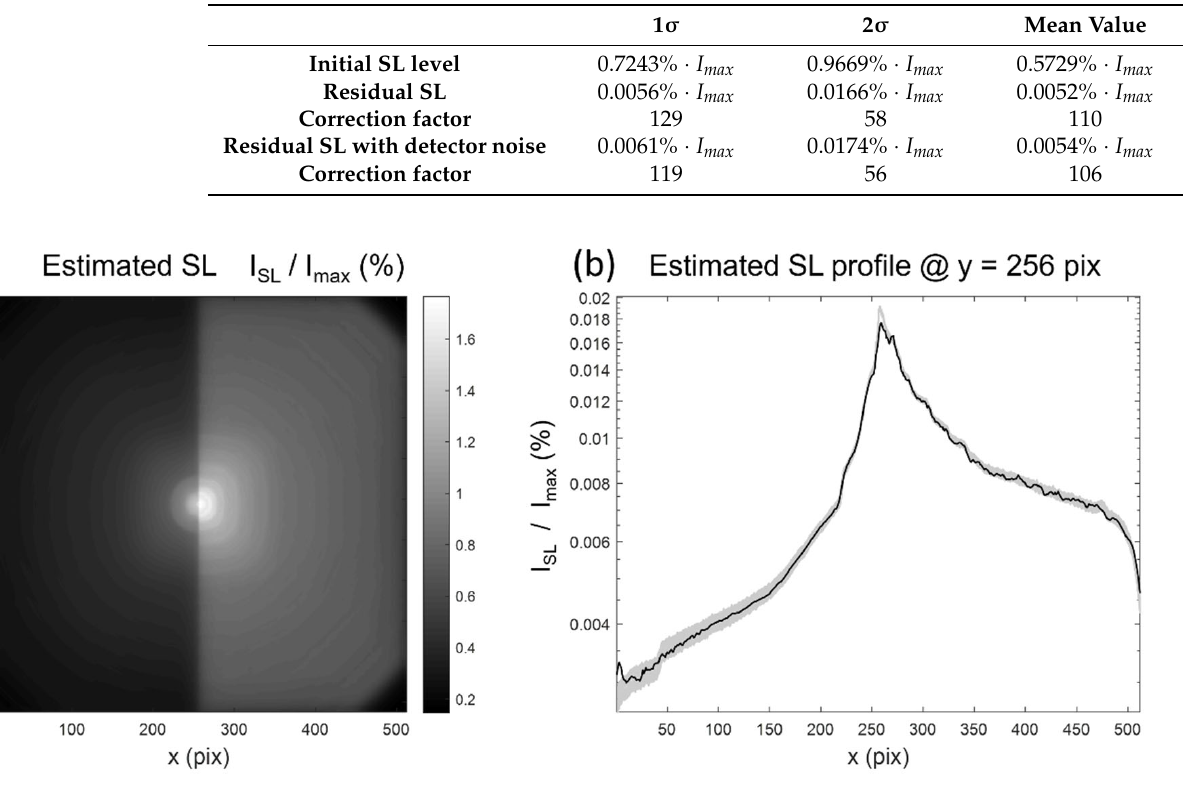
Figure 12. ( a ) SL for the B and W scene, estimated with SPST maps interpolated with the scaling method. ( b ) Profile along x at y = 256. The gray background represents the performance requirement envelope.